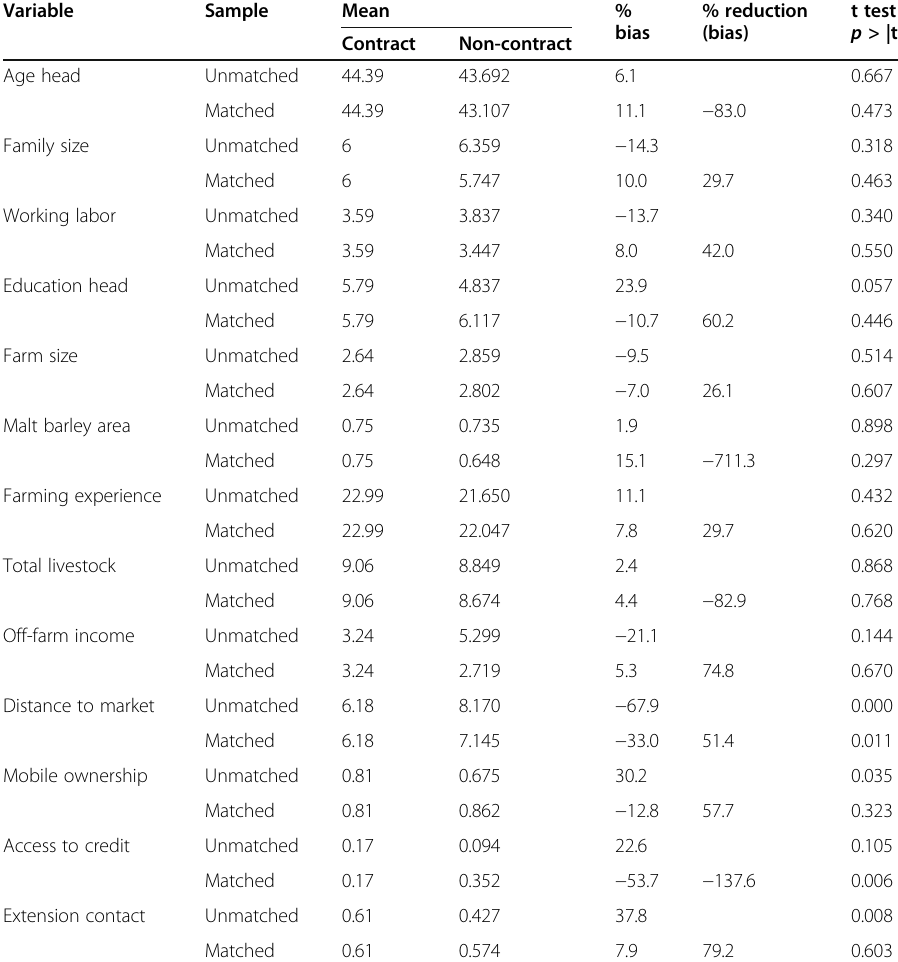
Table 6 t tests for equality of means for each variable before and after the match